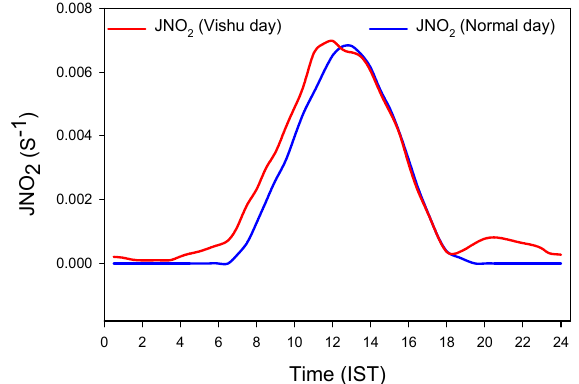
Figure 11. Calculated and model simulated JNO 2 variation during normal days and Vishu day for the year 2018.